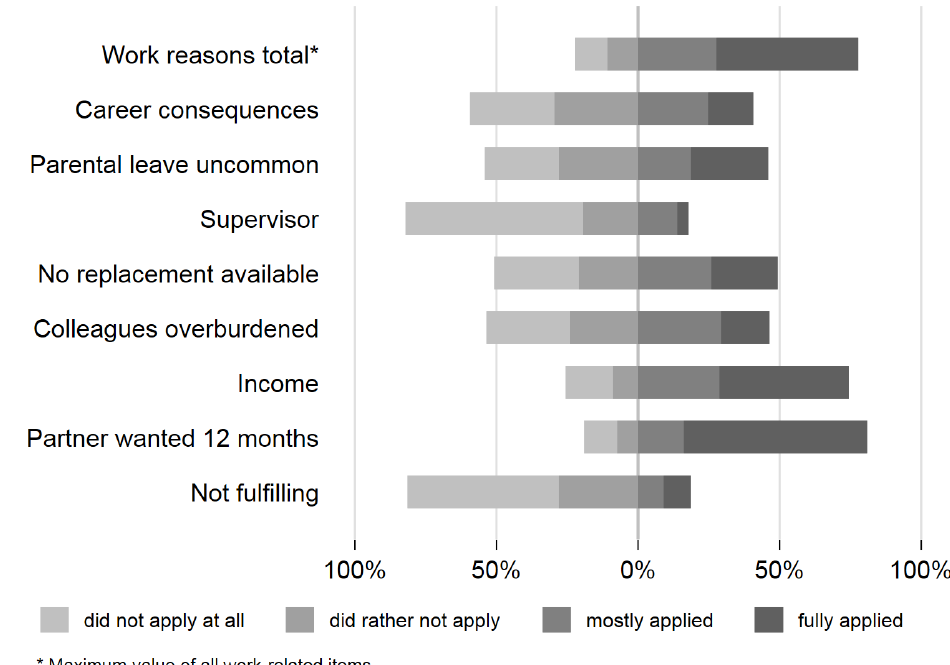
Figure 2. The fathers’ reasons for not taking leave for longer than one or two months. N = 172, weighted results.